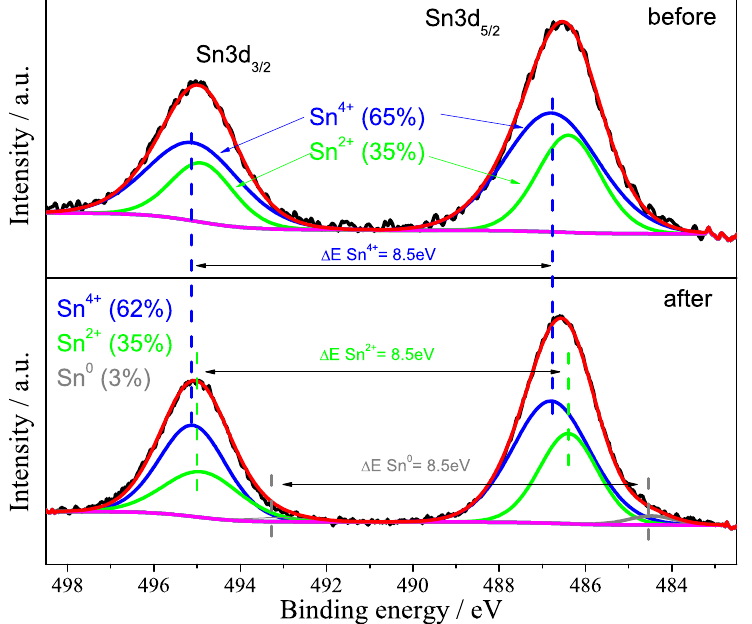
Figure 2. XPS spectra of Sn 3d core level of SnO x /CHI electrode material before and after galvanos- tatic